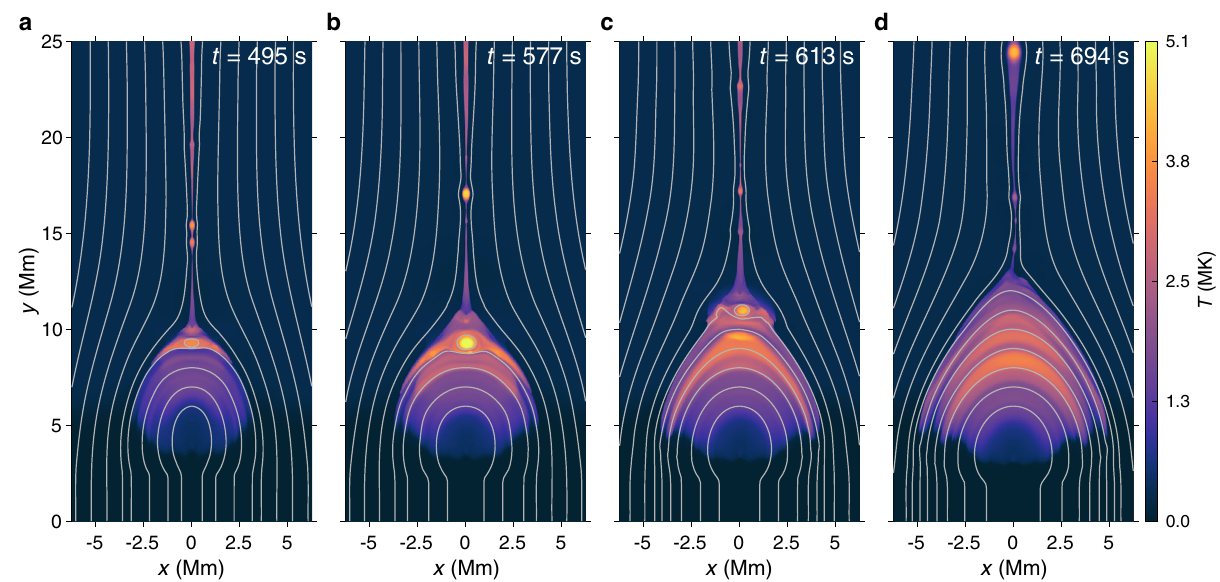
Fig. 5 | Temperature distributionsofthe CS atfour typicalinstants. a – c The CS is fragmentedinto anumberof magneticislands. Arelativelylarge magneticisland is interacting with the fl are loop-top and several islands in the main CS are